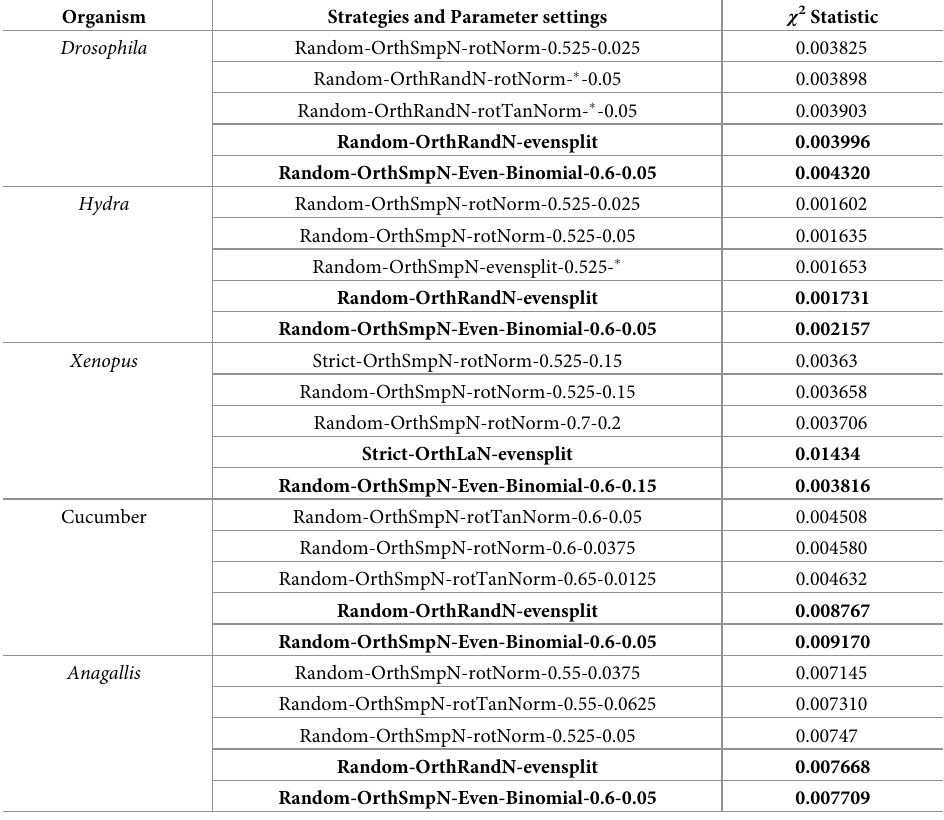
Table 1. Top-ranking